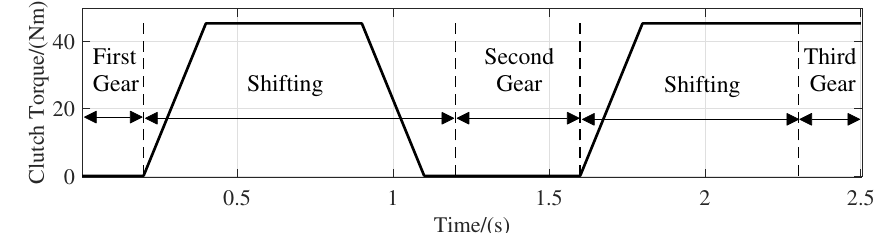
Figure 9. Reference torque trajectory of the clutch.